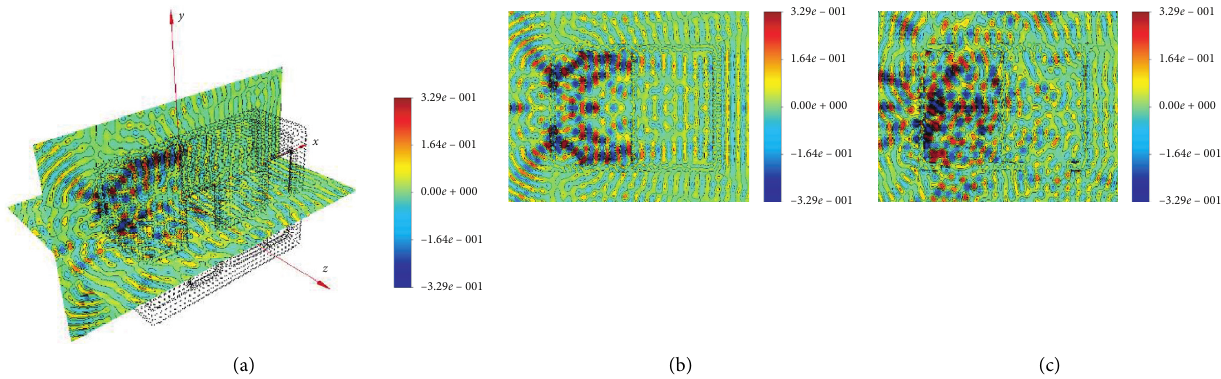
Figure 6: The isometric (a), x - y plane (b), and x - z plane (c) view of the rooms for 1800MHz.